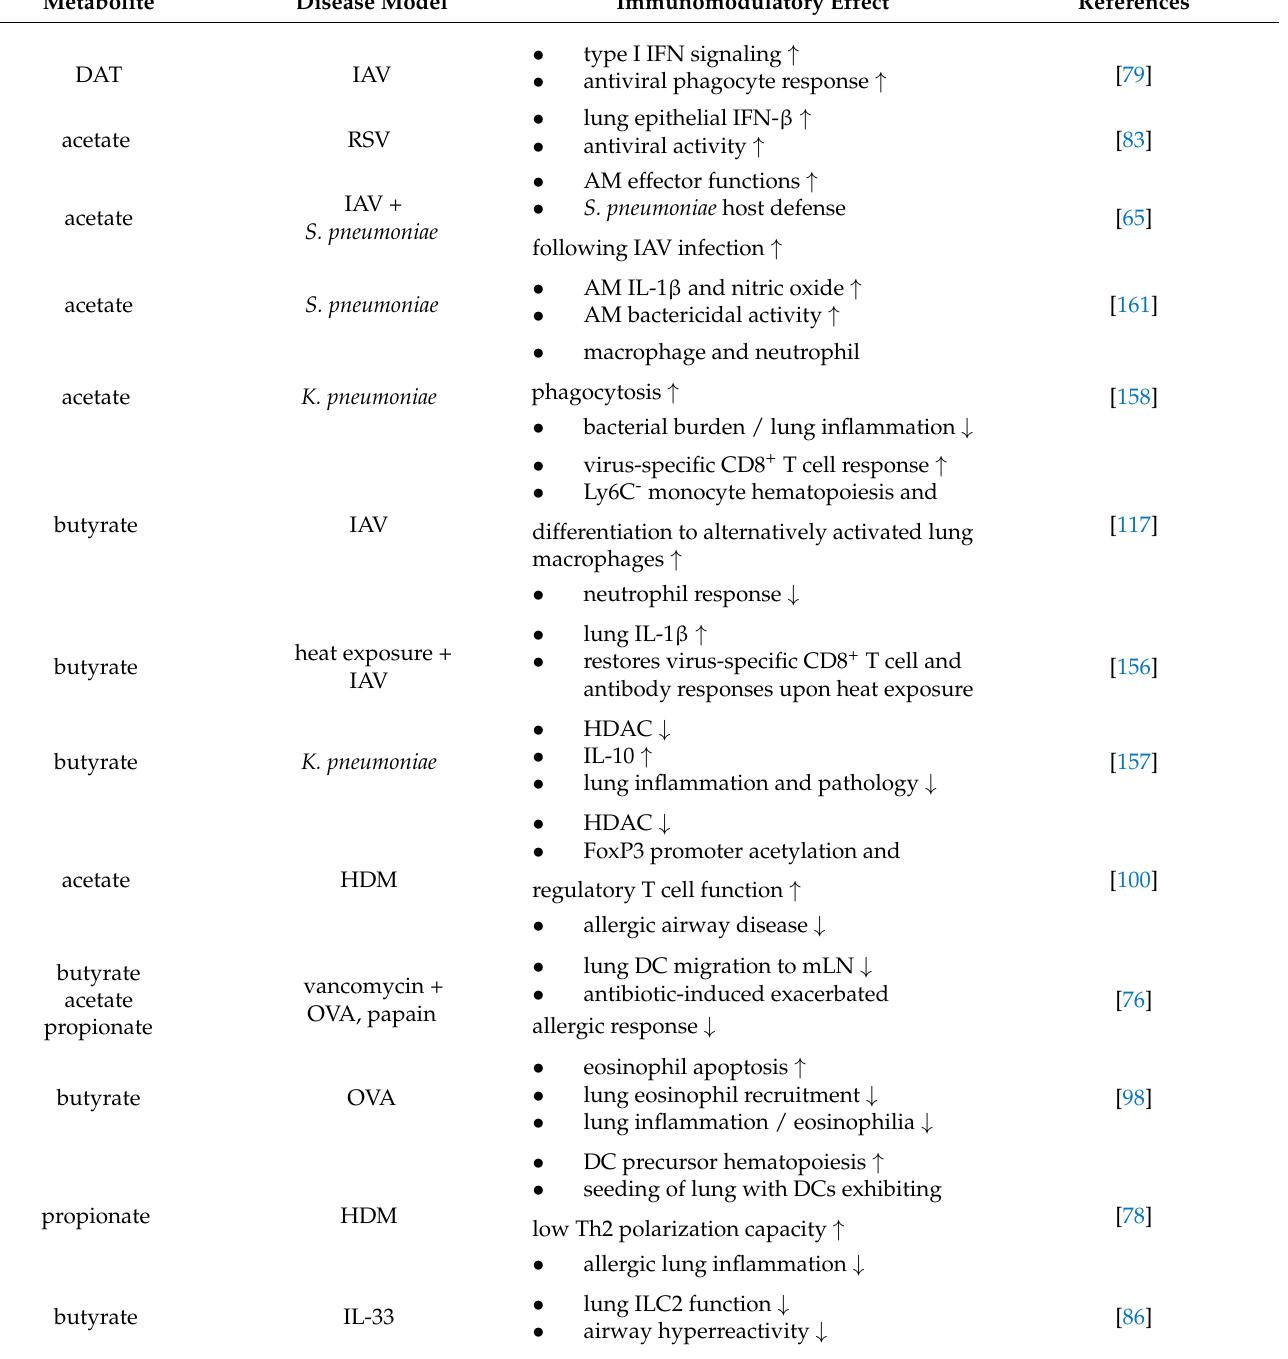
Table 1. Role of commensal-derived metabolites in mouse models of infections and chronic lung disease.